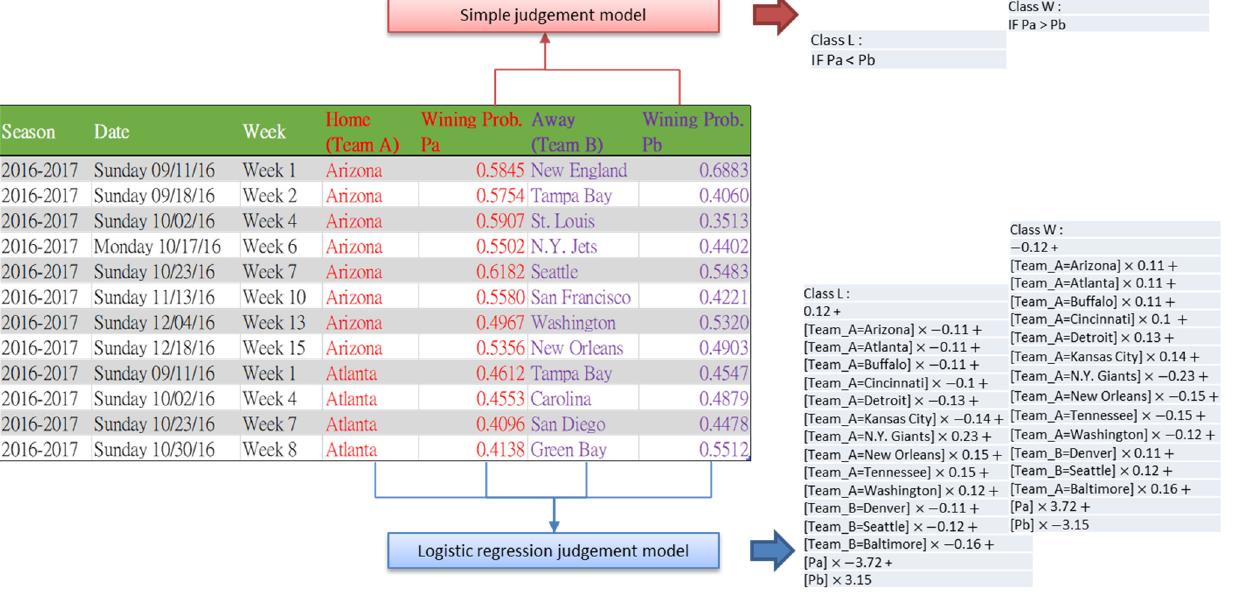
Figure 6. The outcome judgment model in the second stage.